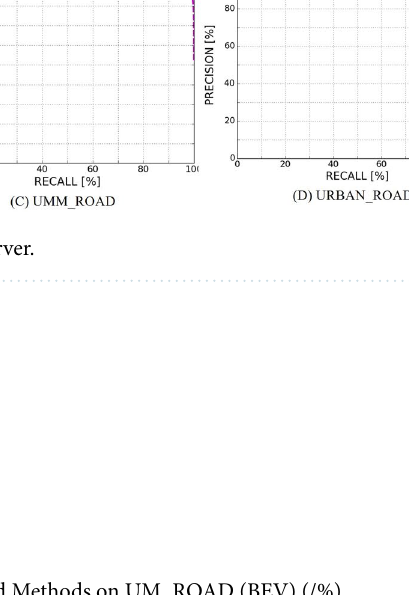
Table 3. Comparison with Several Popular Fusion-based Methods on UM_ROAD (BEV) (/%).